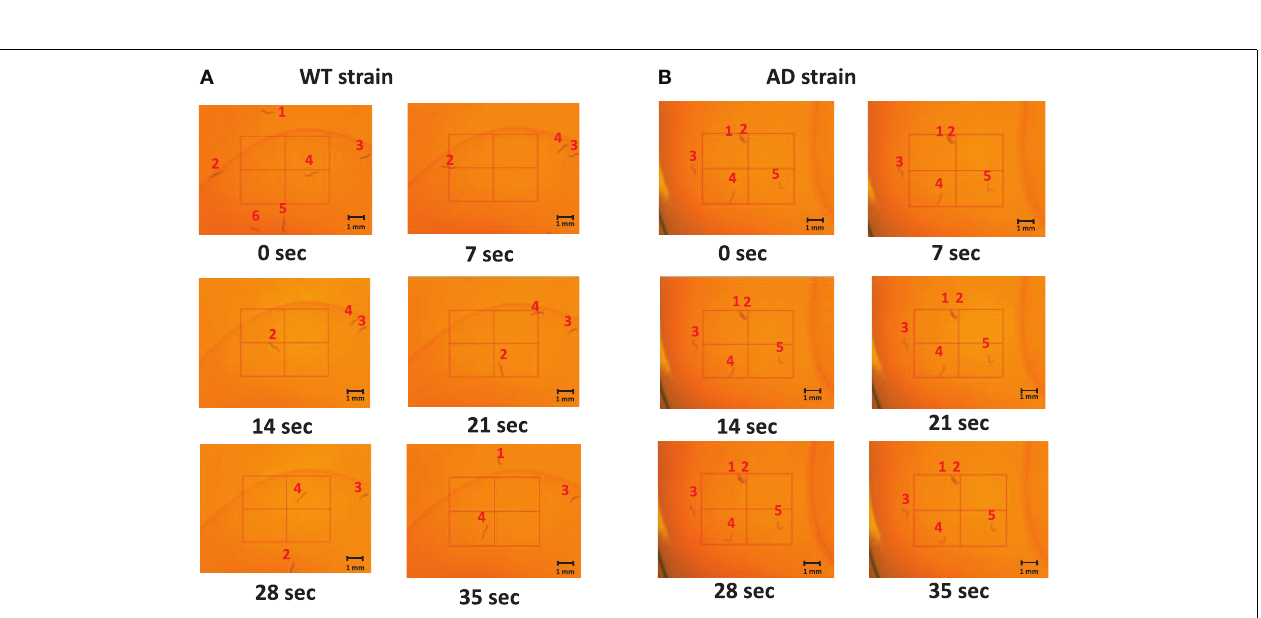
(D) The graph represents the speed for older adult worms measured at the age of day 13 (older age). (E) Comparison of the average speeds for WT (blue) and AD (red) worms at various ages over the course of their life span. Error bars indicate standard error of the mean. ∗ p > 0 . 0001. WT worms (blue); and AD worms (red). See also Table 1 .